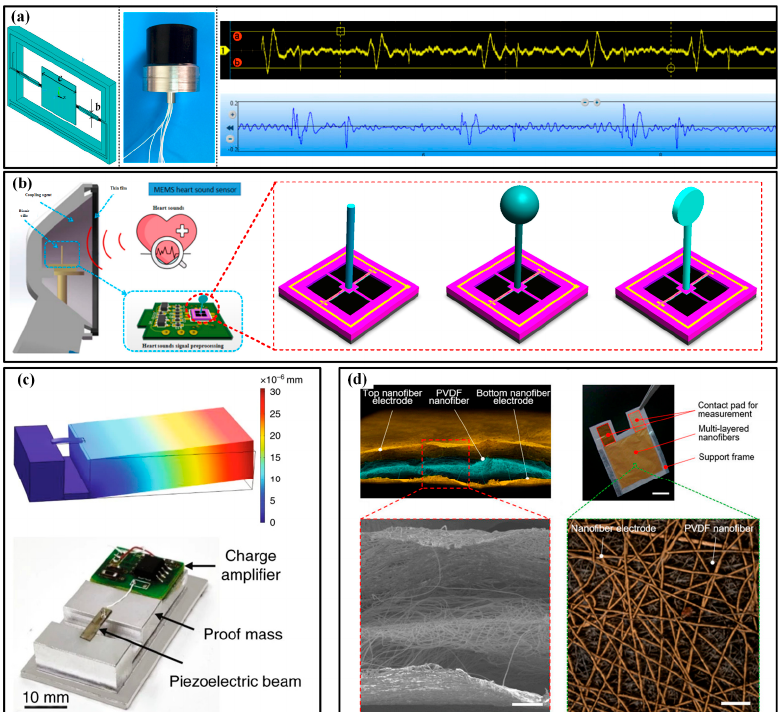
Figure 11. The PPG devices and their applications in monitoring heartbeat: ( a ) the double-beam-block microstructure(left), sensor photo (middle) and comparison of obtained curves (right) between this sensor (yellow) and commercial product (blue) [122] ; ( b ) fish cilium structures for PPG sensors [126] ; ( c ) the PZT-based sensor with a two-stage amplifier [129] ; ( d ) the sensor based PVDF nanofibers [130] . Reproduced with permissions from Elsevier (2022)[126]. Reproduced with permissions from The National Academy of Sciences (2020)[130]. An ECG is another typical signal for assessing the heart state. The research of availa- ble wearable devices mainly focuses on pursuing flexible, dry electrodes that can reliably acquire ECG without conductive glue [131]. Numerous high-conductivity nanomaterials, such as metals, carbons and polymers, are processed to guarantee reliable contact between electrodes and skin in various environments. In the beginning, the efforts were devoted